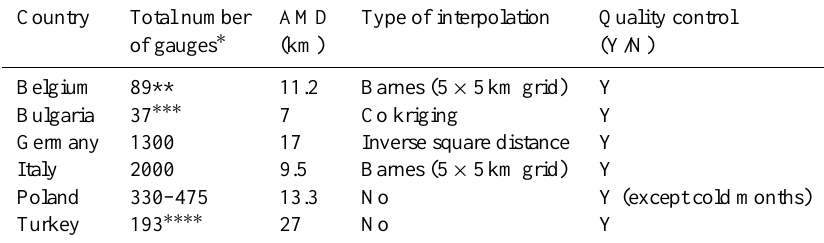
Table 3. Number and density of rain gauges within the H-SAF validation group. Country Type of